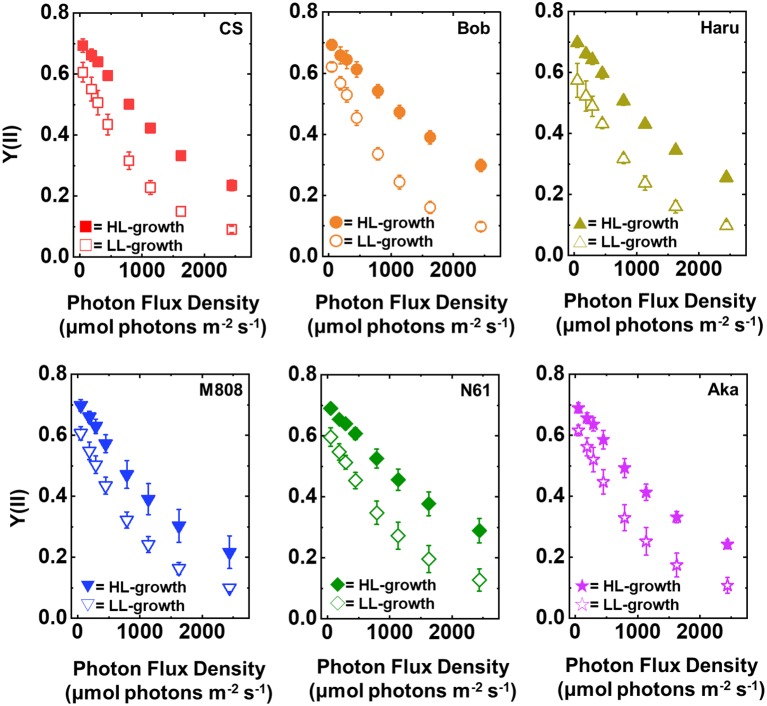
The response of Y(II) to light intensity in six wheat cultivars grown under LL (open symbol) and HL (closed symbol) conditions. The measurement was conducted under atmospheric conditions (21 kPa O2, 40 Pa CO2) at 25°C. Data were expressed as mean ± SD of three to five independent experiments. Red squares indicate the results of CS, orange circles indicate the results of Bob, dark yellow triangles indicate the results of Haru, blue inverted-triangles indicate the results of M808, green diamonds indicate the results of N61, and purple stars indicate the results of Aka.